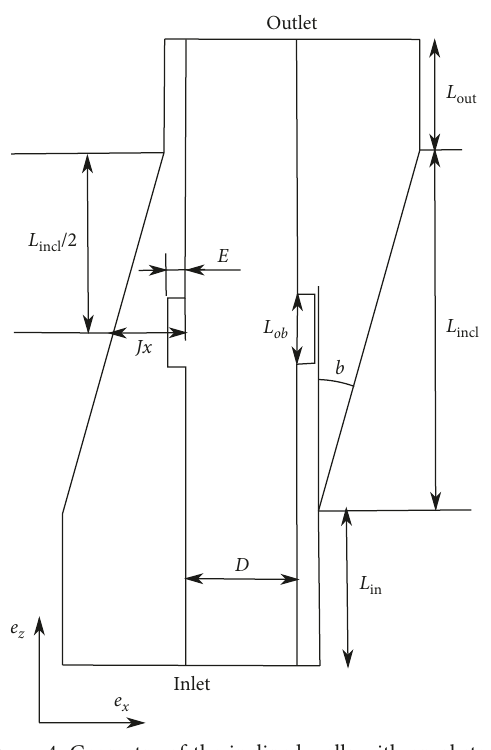
Figure 4: Geometry of the inclined walls with an